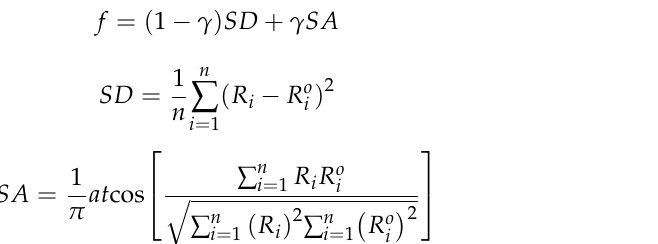
Table 2. 15 sols’ gray panel attitudes, with the new incidence and azimuth.